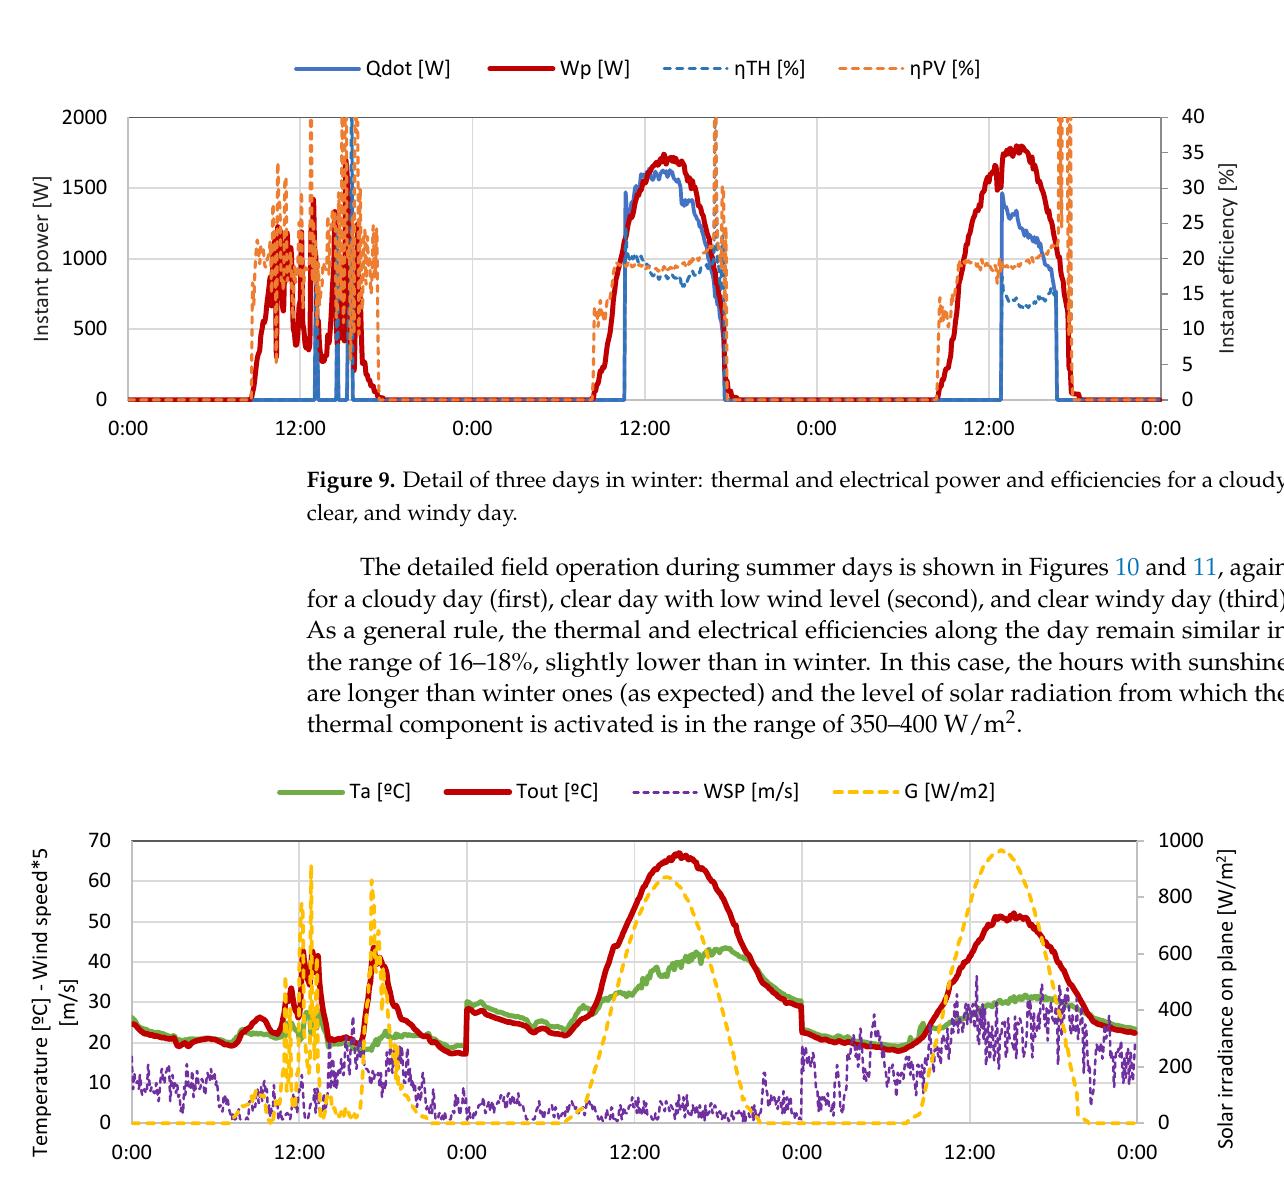
Figure 8. Detail of three days in winter: inlet/outlet temperatures, wind speed and solar irradiance.